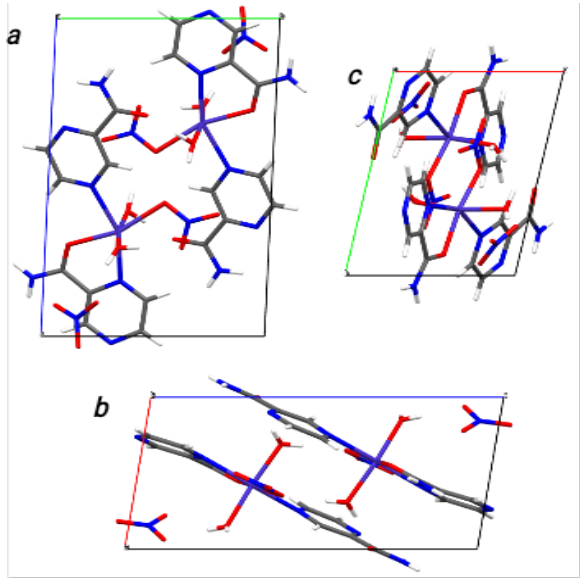
Figure 3. 1D structure showing packing arrangements of compound 2 along the crystallographic a–c